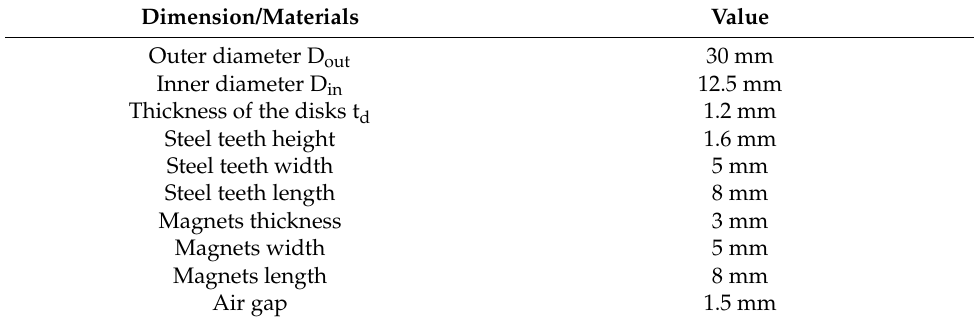
Figure 1. The initial design of the permanent magnet (PM) coupling. Table 1. Coupling specifications.